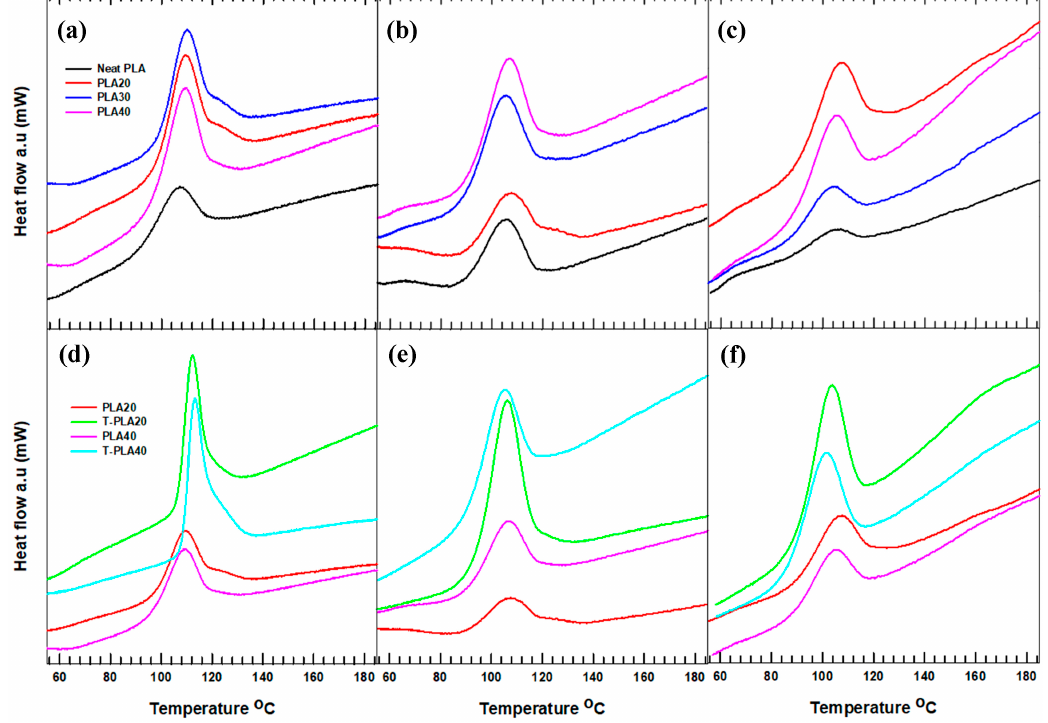
Figure 2. Crystallization thermographs of neat and hybrid composites: the effects of filler loading at cooling rates of ( a ) 5°C/min, ( b ) 10°C/min, and ( c ) 20°C/min and the effects of filler treatment at cooling rates of ( d ) 5°C/min, ( e ) 10°C/min, and ( f ) 20°C/min.